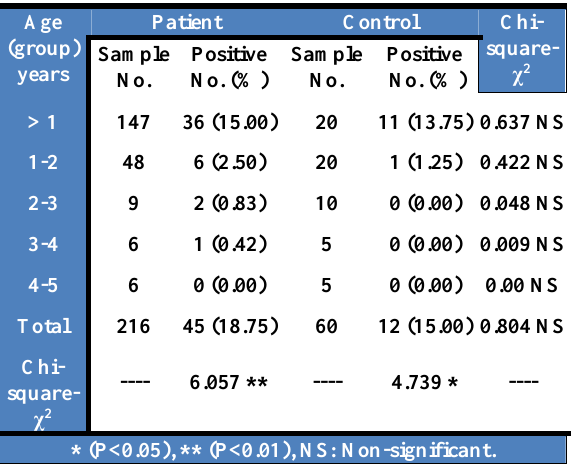
Table, 2: Distribution of toxin A and/or B according to age groups <5 years.